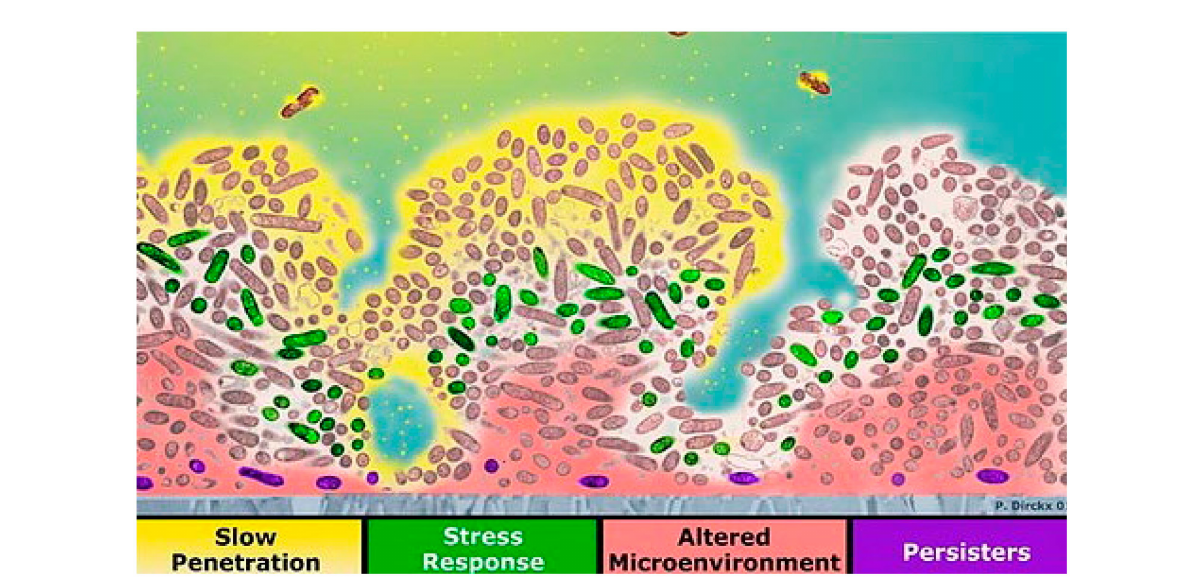
FIGURE 2 Four mechanisms of reduced susceptibility to antimicrobials in biofilm: slow antibiotic penetration (antibiotics shown in yellow), stress response (e.g., green cells), altered microenvironment (pink), and resistant phenotype [purple persister cells; reproduced with permission from Chambless et al.